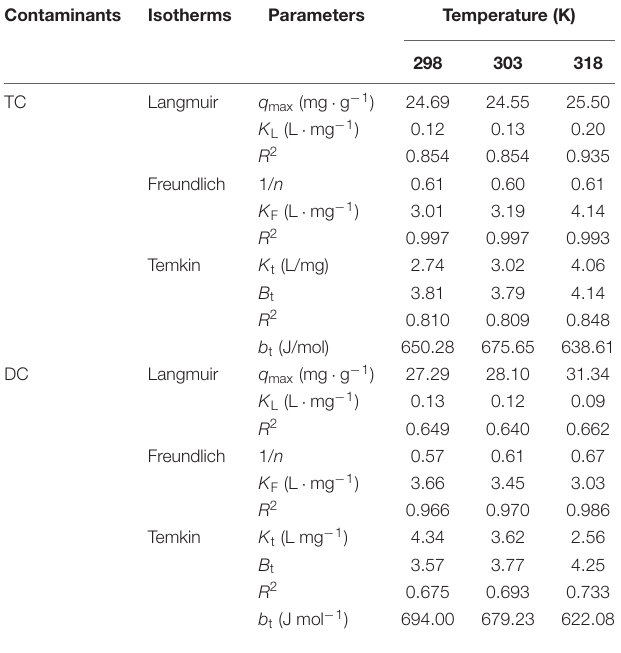
Here, R is the gas constant 8.314 J · mol − 1 · K − 1 , T (K) is the adsorption temperature; K 0 could be calculated by plotting ln( q e / c e ) versus c e and extrapolating c e to zero.